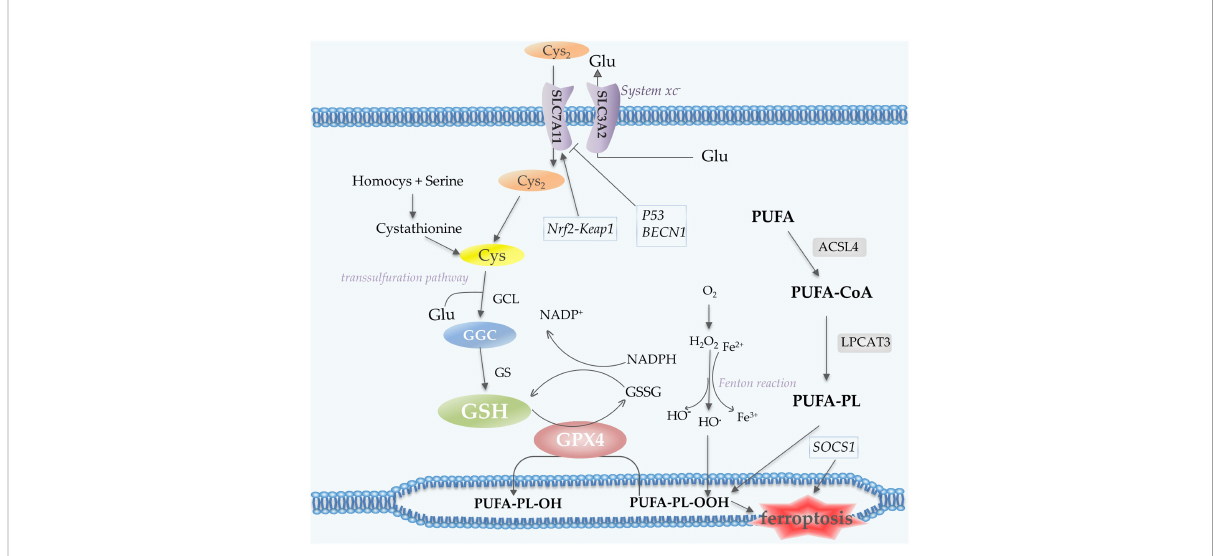
FIGURE 3 Lipid peroxidation and antioxidant processes in ferroptosis. System xc - contains two subunits, SLC7A11 and SLC3A2, which mediate the transport of Cys 2 and Glu. Cys 2 is an ingredient for the synthesis of GSH, which together with GPX4 acts as the reductant for the inhibition of ferroptosis. Cys can also be generated via the transsulfuration pathway. PUFA undergoes a series of oxidation reactions and the product PUFA- PL-OOH leads to the occurrence of ferroptosis. Fenton reaction contributes to lipid peroxidation. P53 and BECN1 function as inhibitors of SLC7A11, while Nrf2-Keap1 pathway promotes the expression of this subunit. Abbreviations: Cys 2 , cystine; Glu, glutamate; GSH,